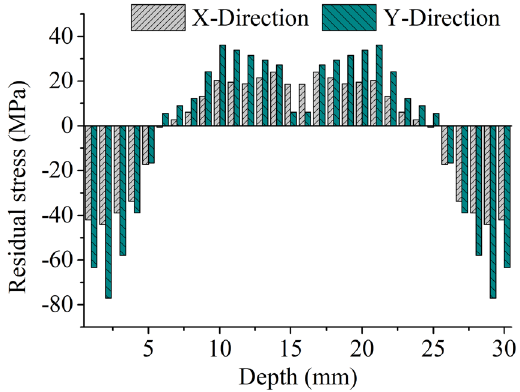
Figure 4: Residual stress in each layer of the